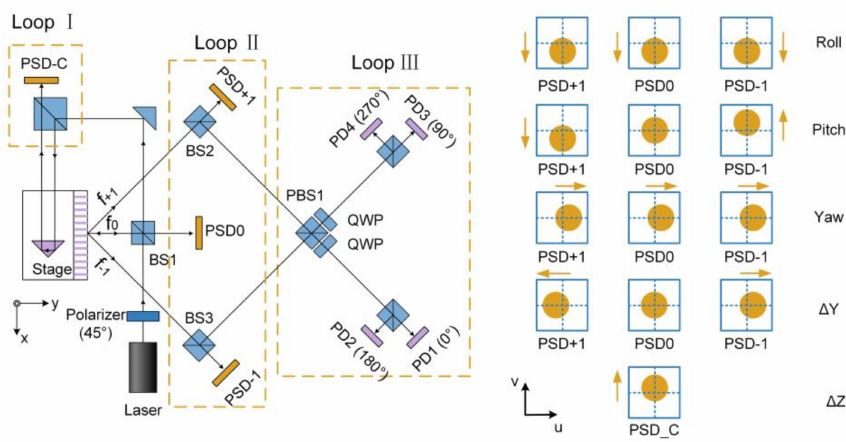
Figure 8. The high-resolution optical encoder for 6-DOF motion